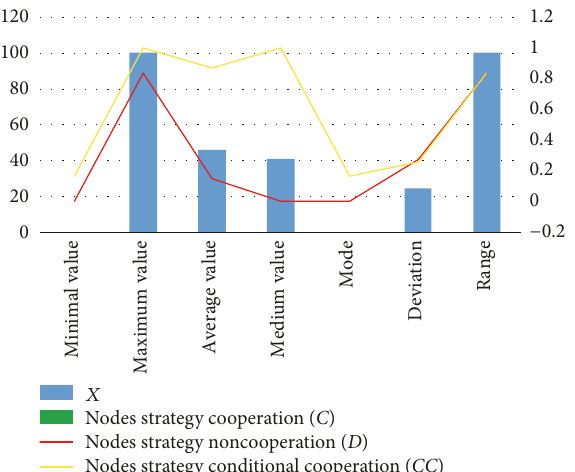
Figure 18: The state of population when 𝑥 = (0.0001, 0.857–0.0001, 0.142). Table 12: The statistical analyses of strategies 𝐶 , 𝐷 , and 𝐶𝐶 .